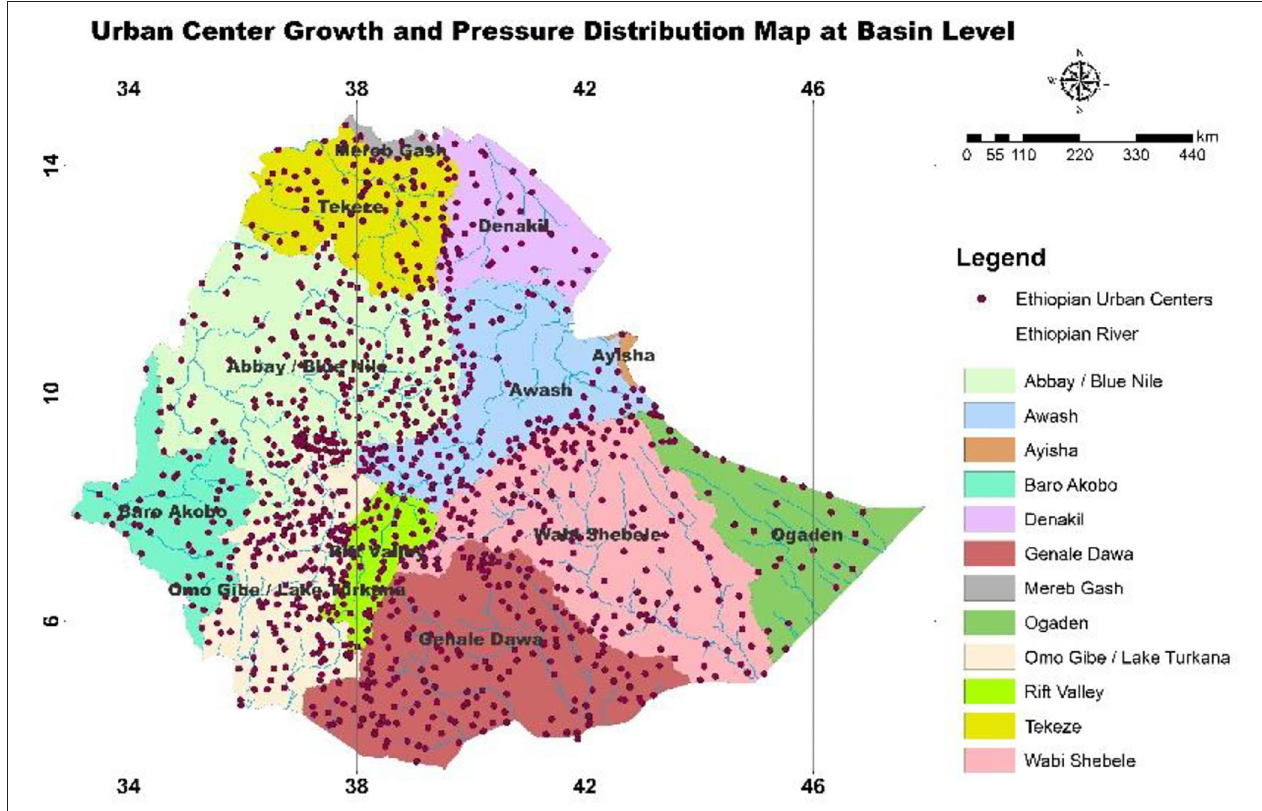
FIGURE 4 | Distribution of urban centers by major river basins. Source: GIS analysis by superimposing urban centers and basin thematic layers (2022).